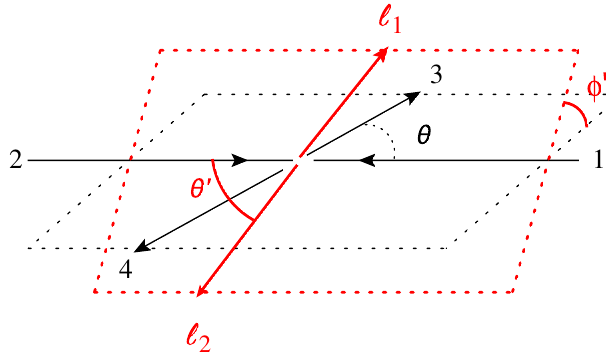
Figure 24 . We represent the internal loop momentum in the center of mass frame. The angle between the loop momentum and ~p = − ~p is θ 0 , while the angle between the plane spanned by 1 2 ~‘ ( ~p ) and the plane ( ~p ) is φ 0 . θ is then the usual scattering 1 , 1 1 , ~p 2